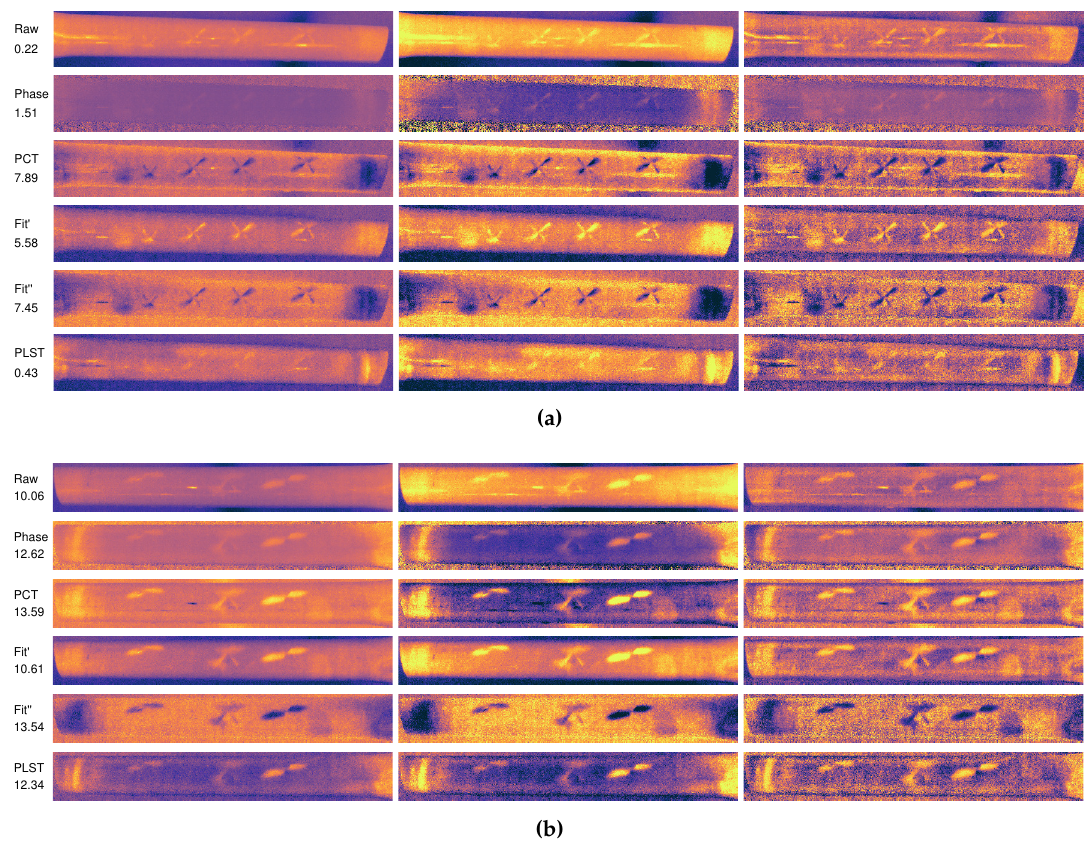
Figure 11. Images resulting from the infrared inspection during heating using a 10-second pulse and 2000W. ( a ) Side A with impact damage from 1 to 6J. ( b ) Side B with impact damage from 7 to